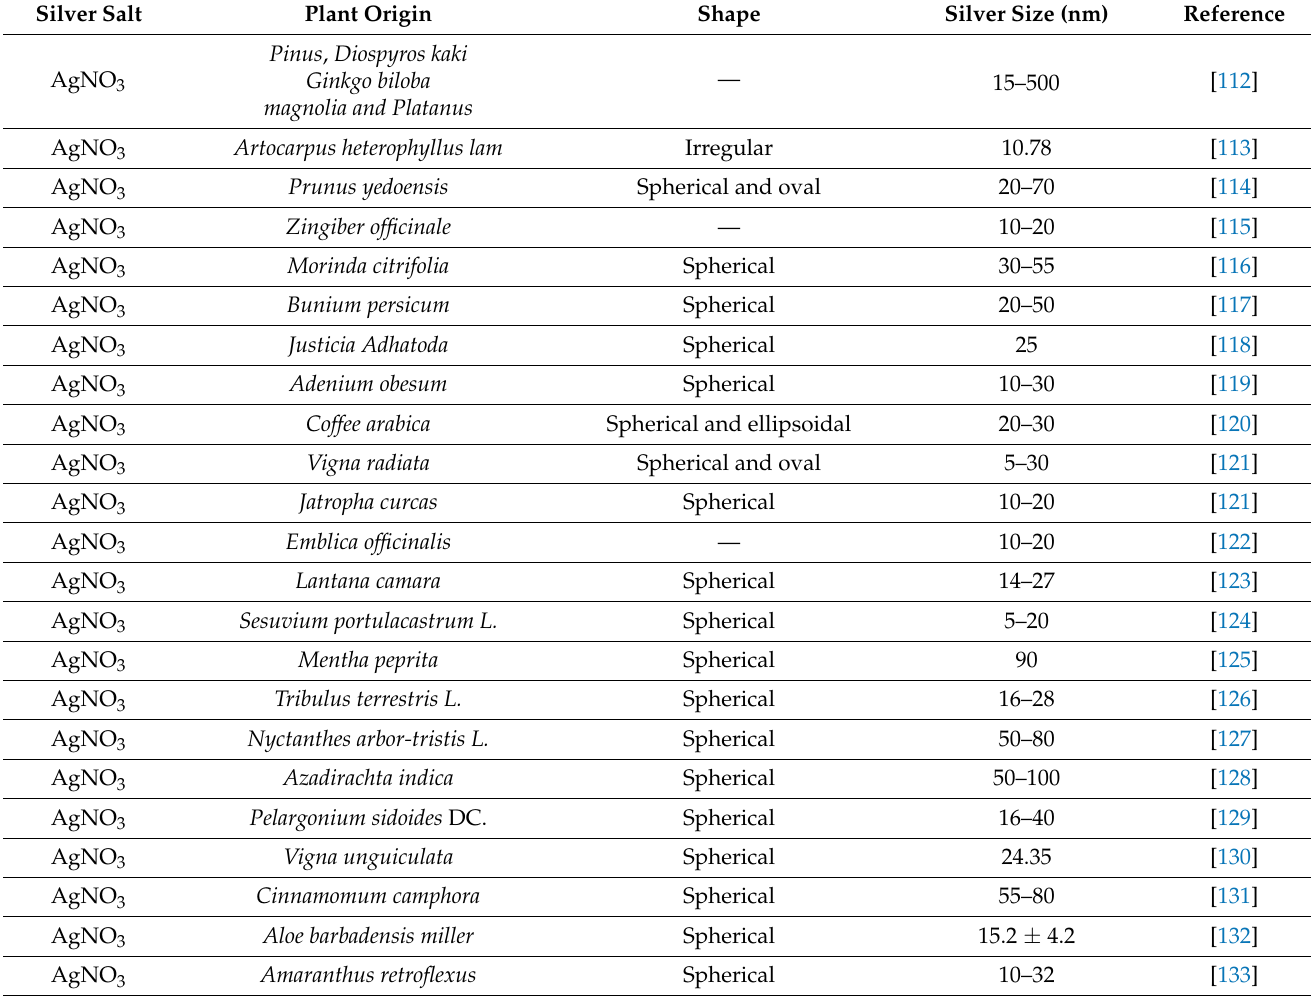
Table 6. Biological method of synthesis of silver NPs using plants extracts as a reducing